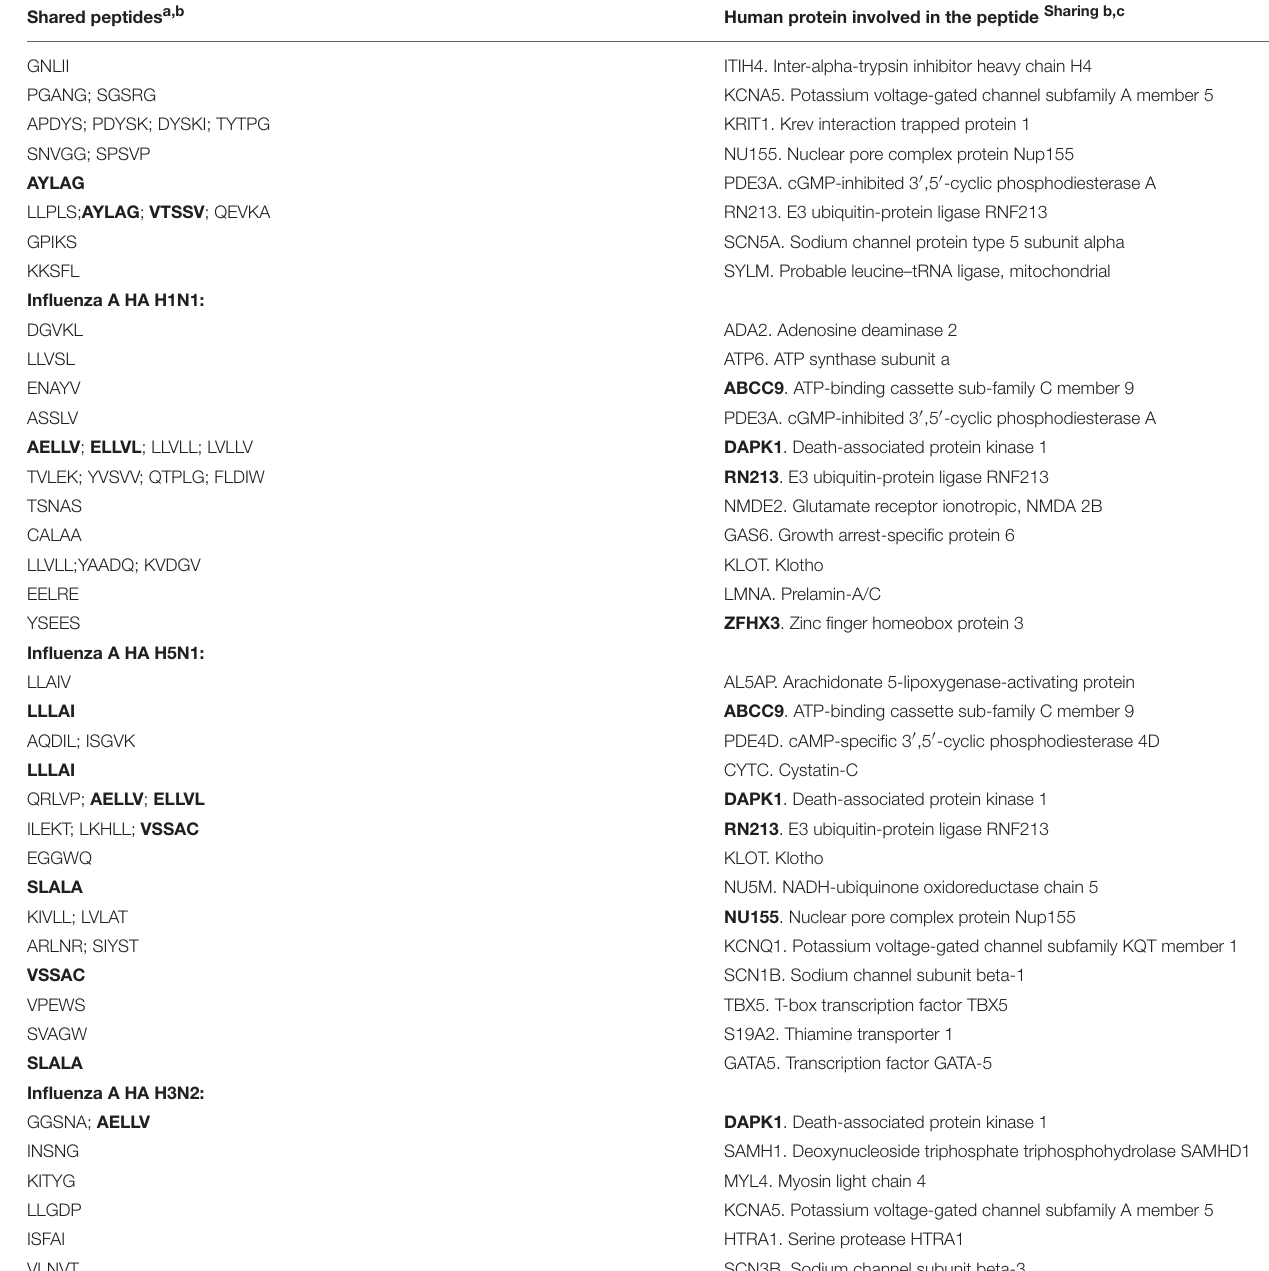
Shared peptides